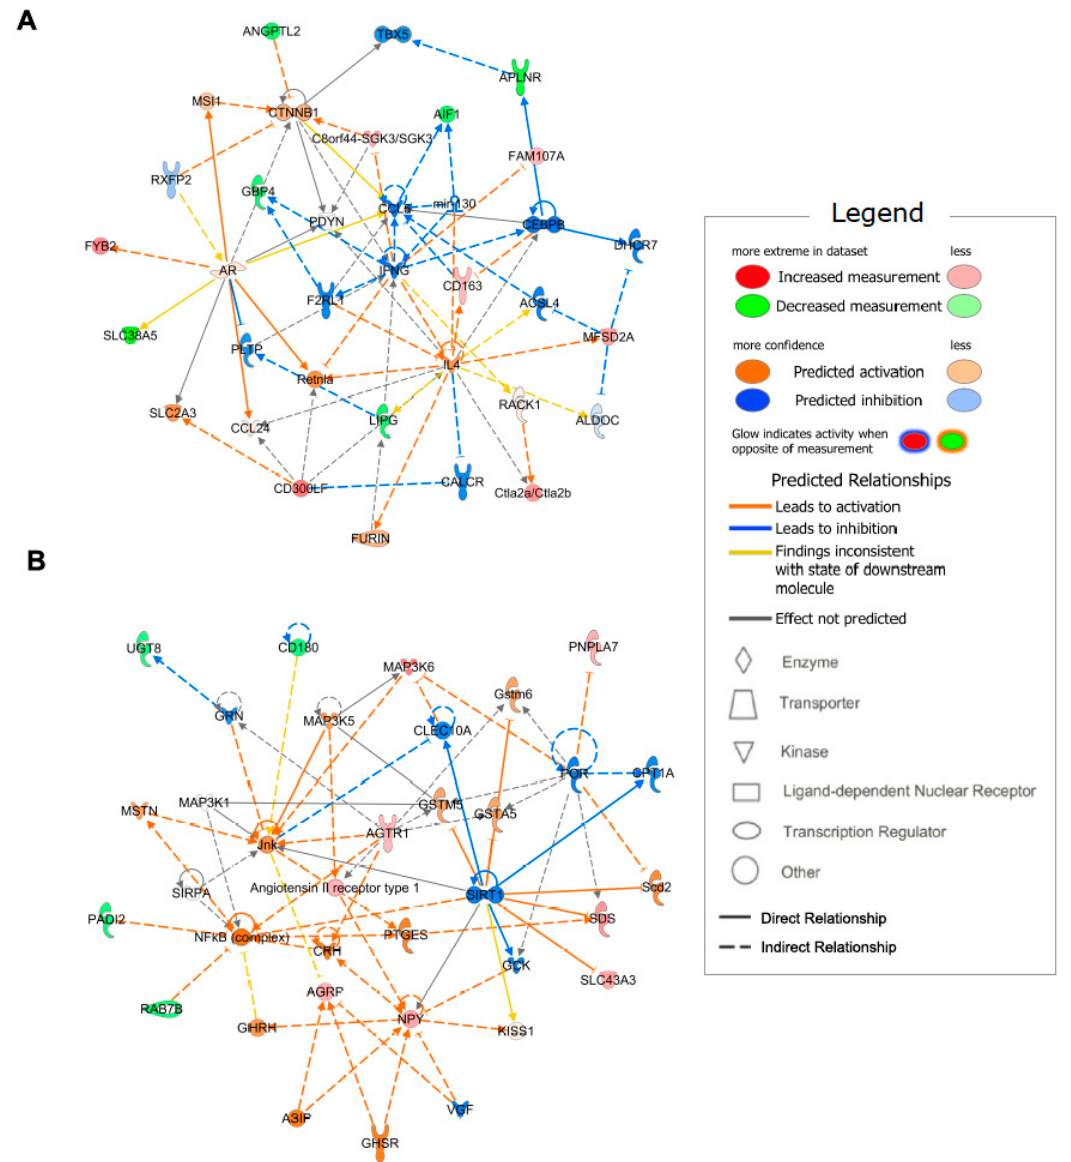
Figure 4. Identification of gene network. Networks obtained using IPA of 70 DEGs in only hypothalamus with FDR ≤ 0.05 and abs(log2FC) > 1.0 in fasted mice compared with those of fed mice. The networks with the highest score are exhibited. Genes in green were downregulated and red were upregulated. ( A ) The network with a score of 23 is associated with lipid metabolism, molecular transport, and small-molecule biochemistry, consisting of Angptl2 , Aplnr , and Lipg . ( B ) The network with a score of 19 is associated with digestive system development and function, lipid metabolism, and molecular transport, consisting of Agrp and Npy .